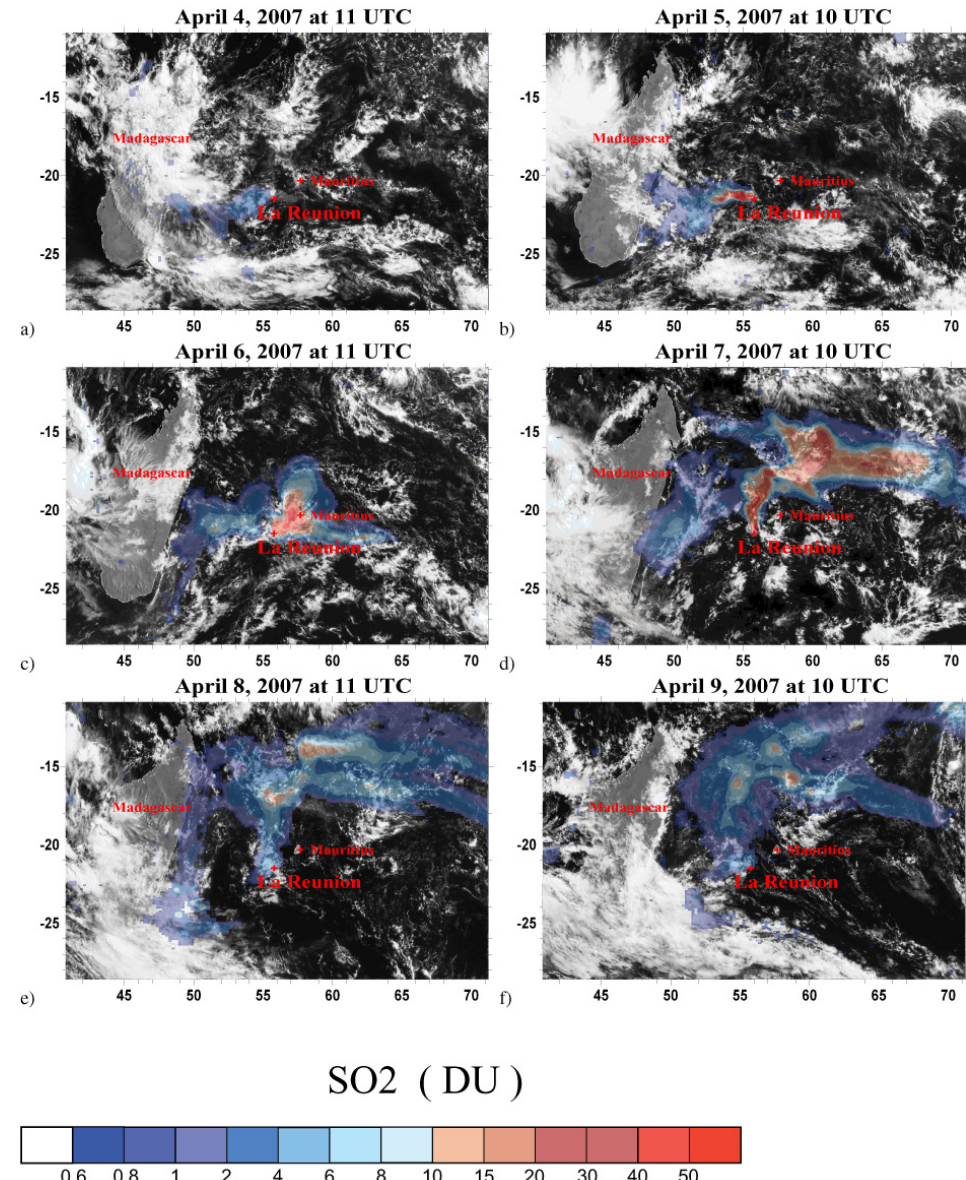
Fig. 2. SO 2 mass burden (Dobson Units) measured by OMI superimposed on the Meteosat visible channel, on 4 April at 11:00UTC (a) , 5 April at 10:00UTC (b) , 6 April at 11:00UTC (c) , 7 April at 10:00UTC (d) , 8 April at 11:00UTC (e) and 9 April at 10:00UTC (f) .